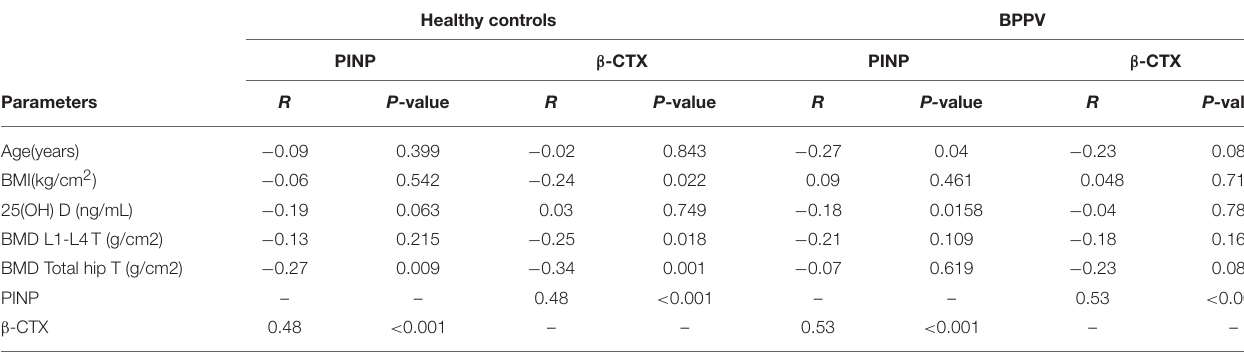
TABLE 3 | Logistic regression analysis of the potential link between BPPV and variables. Variables Odds ratio P -value 95%CI